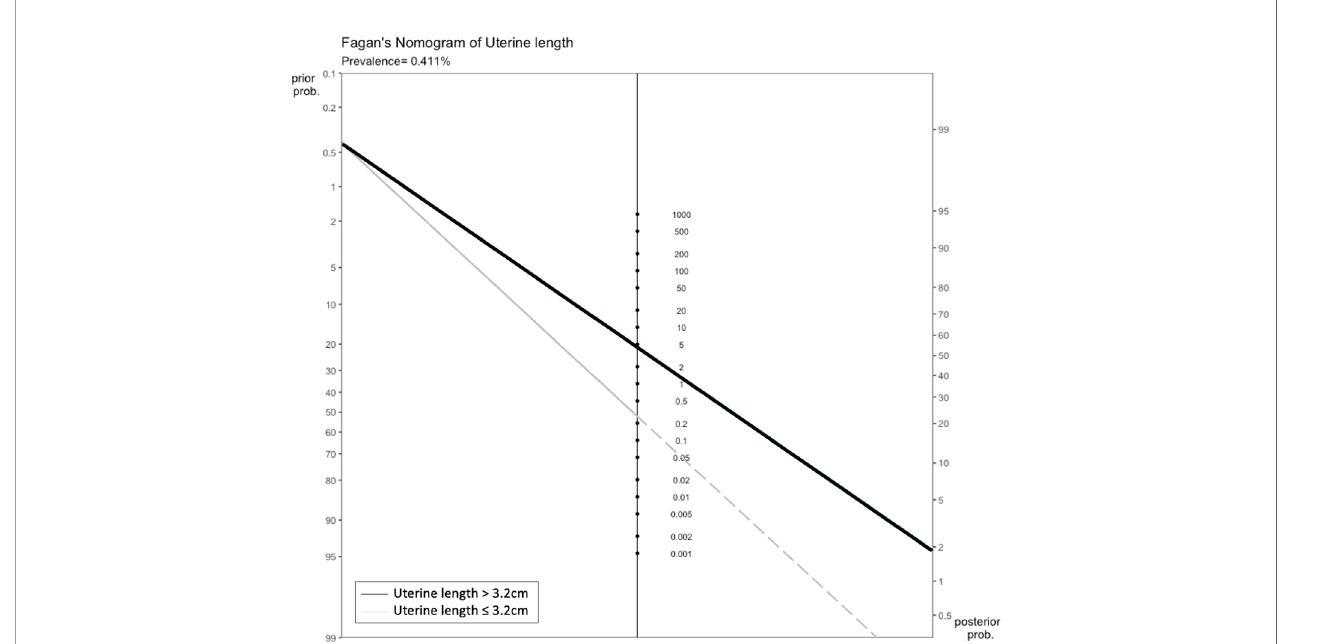
FIGURE 6 | Fagan ’ s nomogram of uterine